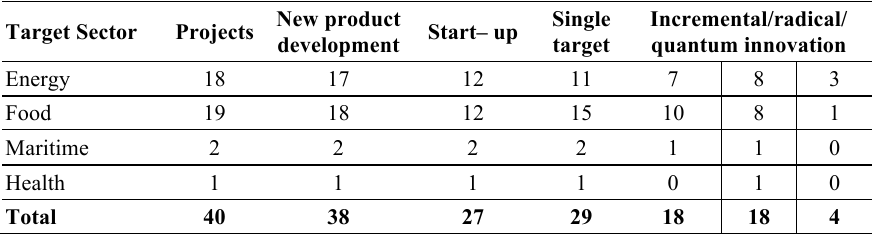
Table 1. Overview of projects in the